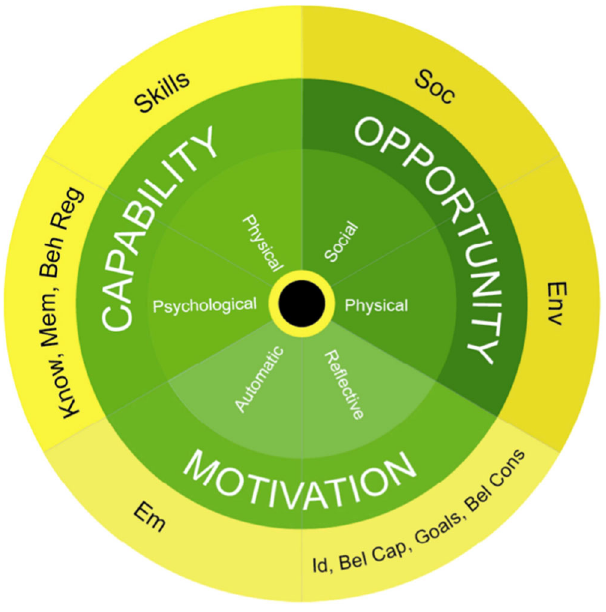
Fig. 1 TDF domains linked to COM-B components 48